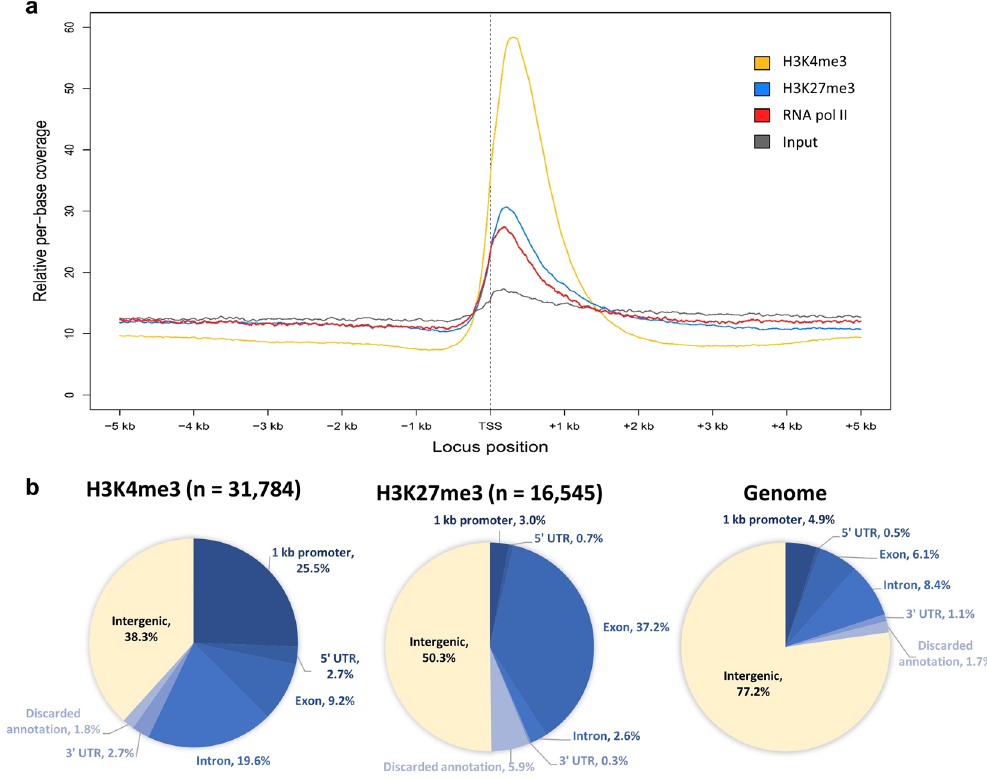
Figure 1. Genomic distribution of H3K4me3 and H3K27me3 in E. grandis developing xylem. ( a ) Relative per- base coverage of H3K4me3, H3K27me3, RNA pol II and input control libraries across annotated transcription start sites (TSS). ( b ) Genomic features coinciding with H3K4me3 and H3K27me3 ChIP-seq peak summits. The proportion of each annotation in the genome is indicated on the far right for